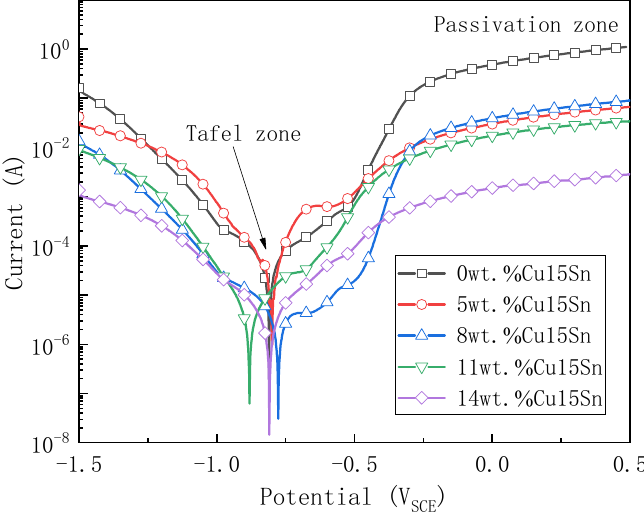
Figure 4. Effects of Cu-Sn addition on potentiodynamic polarization curves of Fe-Cu-Co pressureless sintering alloys.